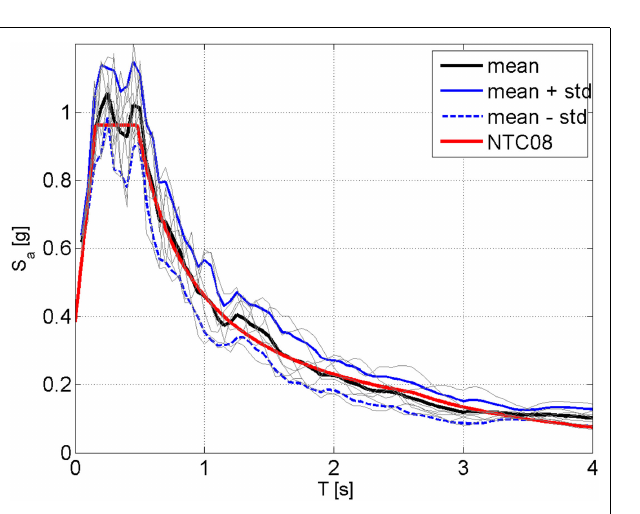
FIGURE 2 | Response spectra (corresponding to 5% viscous damping) of the seven artificial records .